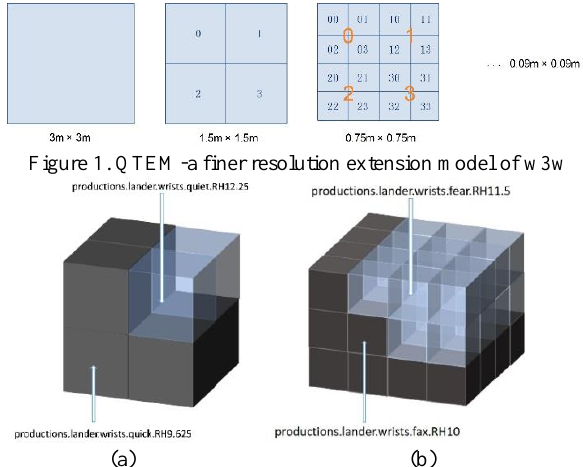
Figure 2. Blocks representing the 3D space. (a) blocks of 1.5m resolution; (b) blocks of 0.75m. (dark blocks represent occupied space, while light colour blocks represent free